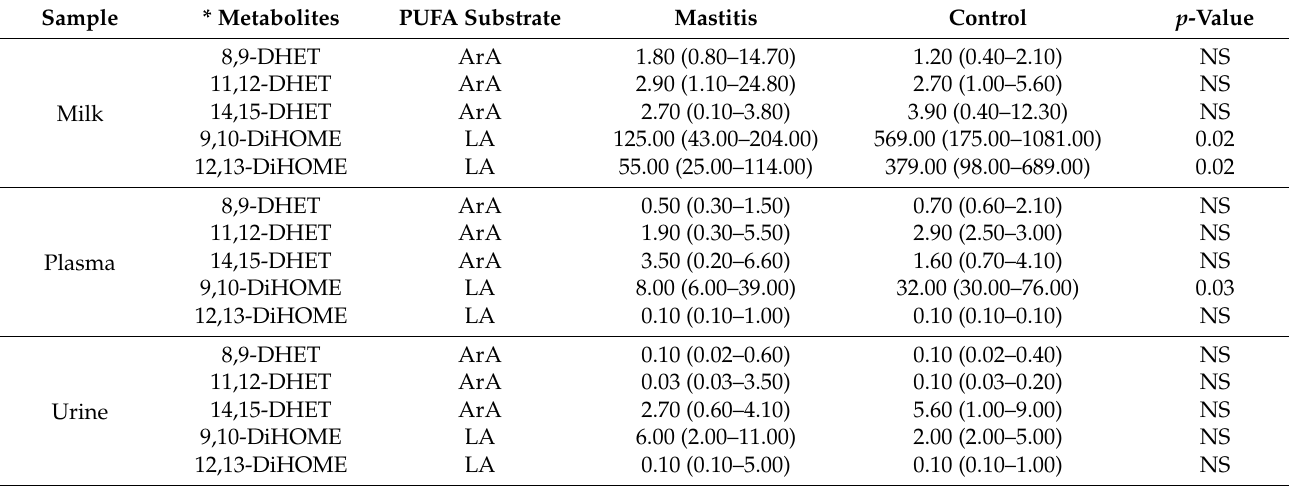
Table 3. Soluble epoxide hydrolase-derived (dihydroxy) epoxy fatty acids in milk, plasma, and urine of systemic coliform mastitis and healthy control cows (median and range, n =